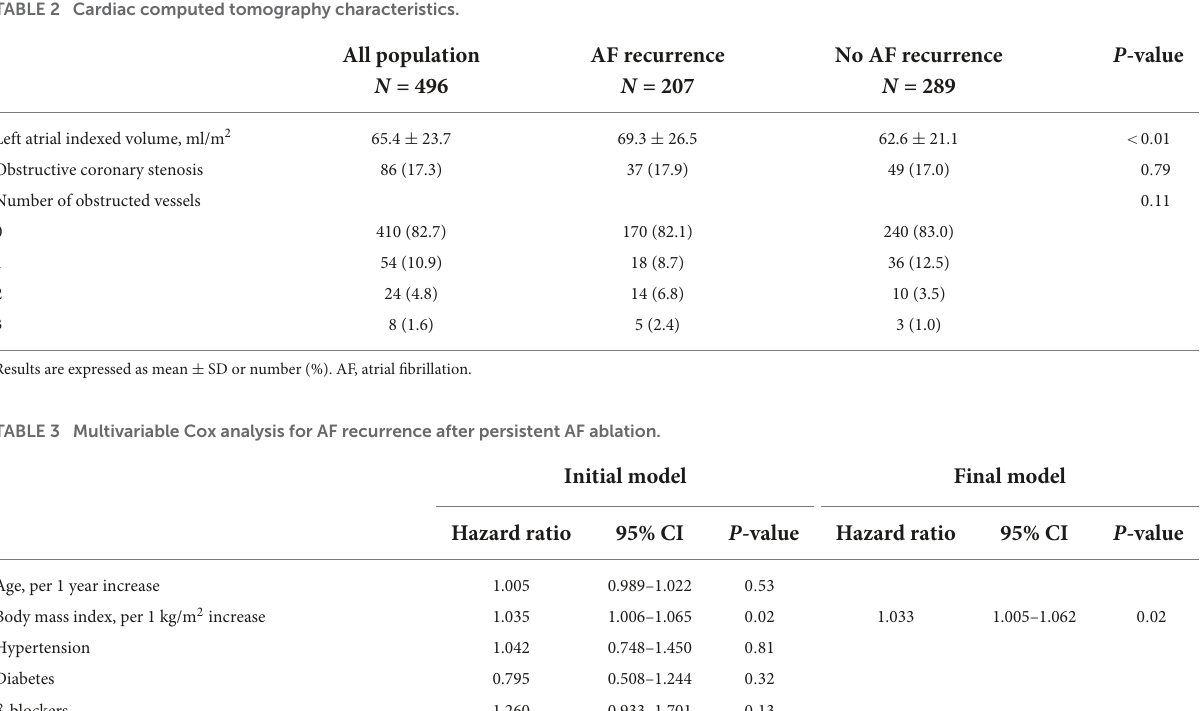
TABLE 2 Cardiac computed tomography characteristics.